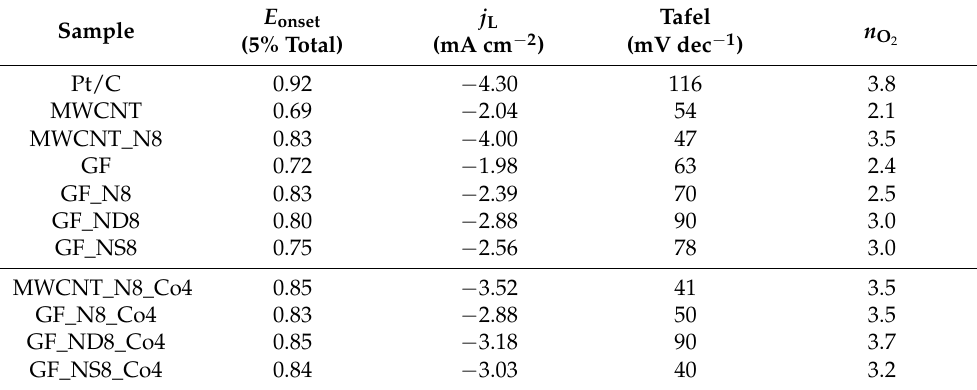
Table 3. Onset potentials ( E onset ), diffusion-limiting current density values ( j L, at 1600 rpm), and Tafel slopes and determined from the ORR LSV curves in O 2 -saturated 0.1 M KOH and the mean value of number of electrons transferred for O 2 molecule ( n O 2